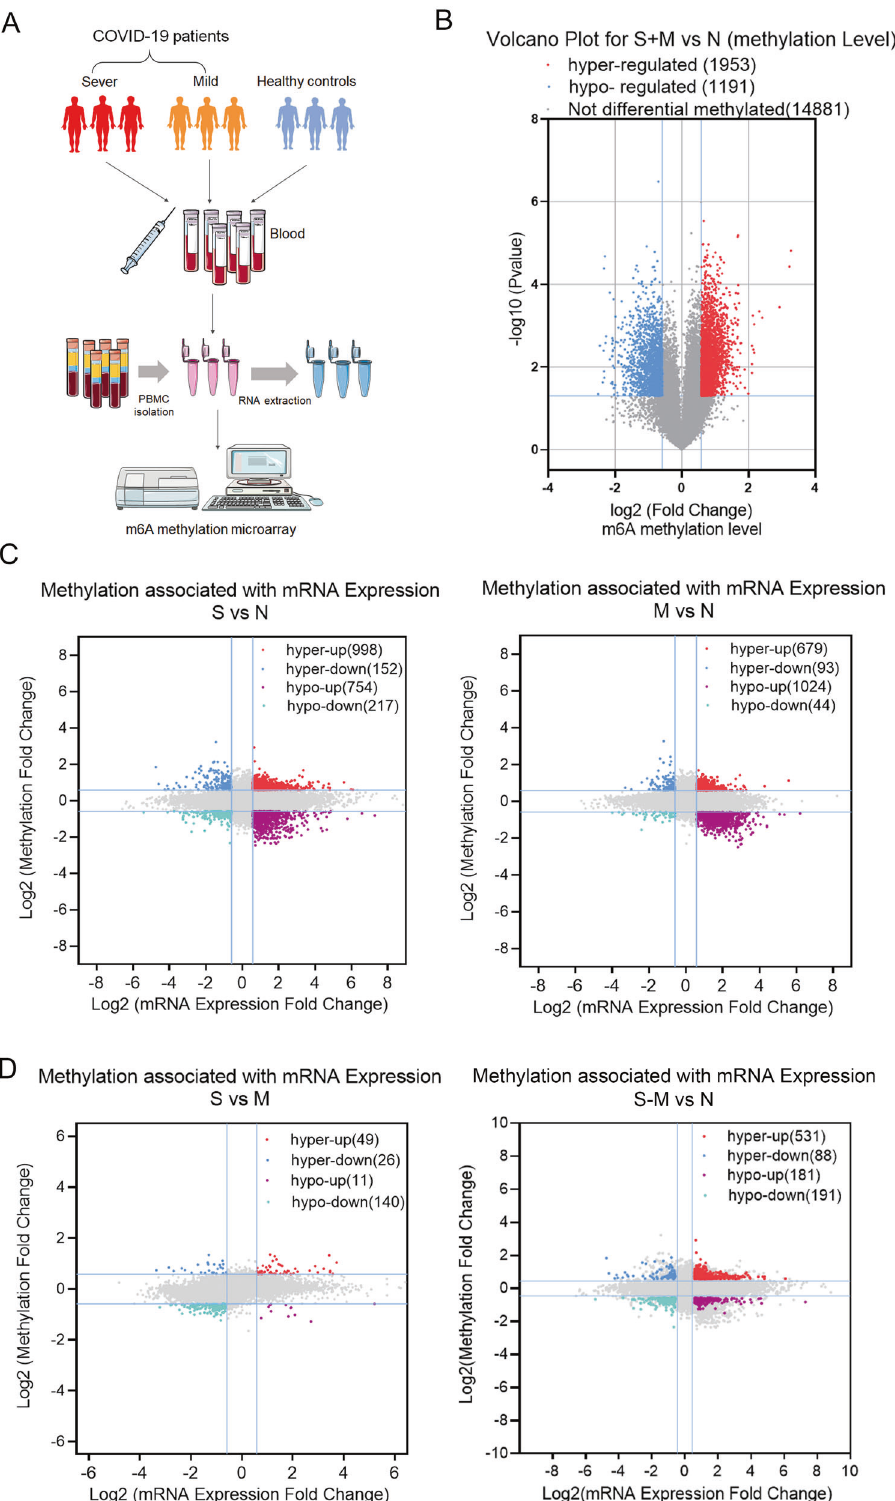
Fig. 1 Global m6A levels are increased in PBMC of COVID-19 patients and showed differentially m6A-modi fi ed transcripts. A Experimental design. B Volcano plot showing abnormally methylated mRNAs in group S (left) and M (right), as compared with group N (FC > 1.5, P < 0.05). C Volcano plots showing the correlation between log2 fold change (FC) of differentially expressed transcripts and log2 FC of differentially m6A-methylated transcripts in groups S and M in comparison with group N separately. D Volcano plots of log2 FC of differentially expressed transcripts and aberrantly methylated transcripts in group S in comparison with group M (left) and the fi gure on the right showed differentially genes only in group S compared with group N (color plots in four quadrants) but not in M compared with N (gray plots in four quadrants) (FC > 1.5, P <